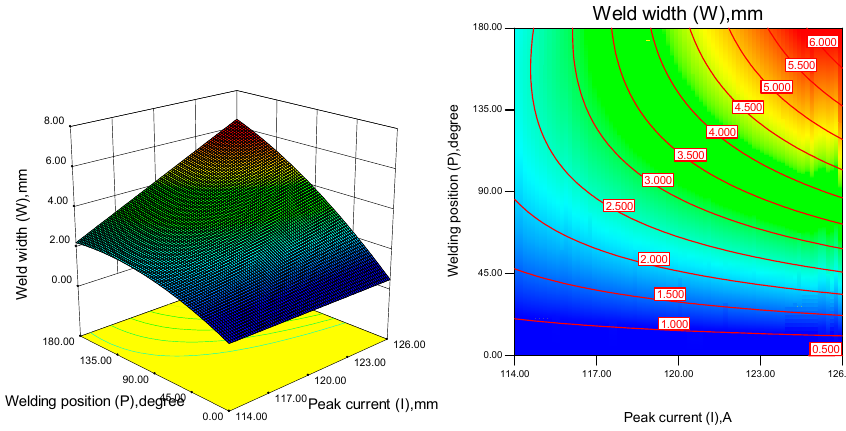
Figure 17. Interaction of peak current and welding position on weld width.